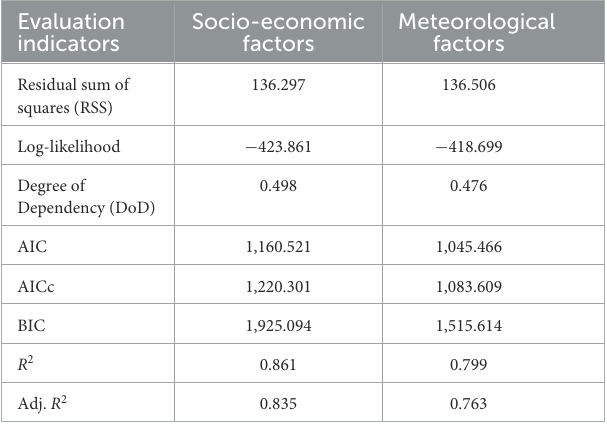
TABLE 1 Diagnostic information of MGWR